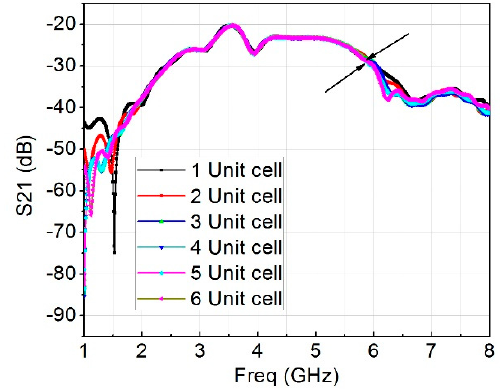
Figure 3. S21 plot for various quantity of metamaterial unit cell.